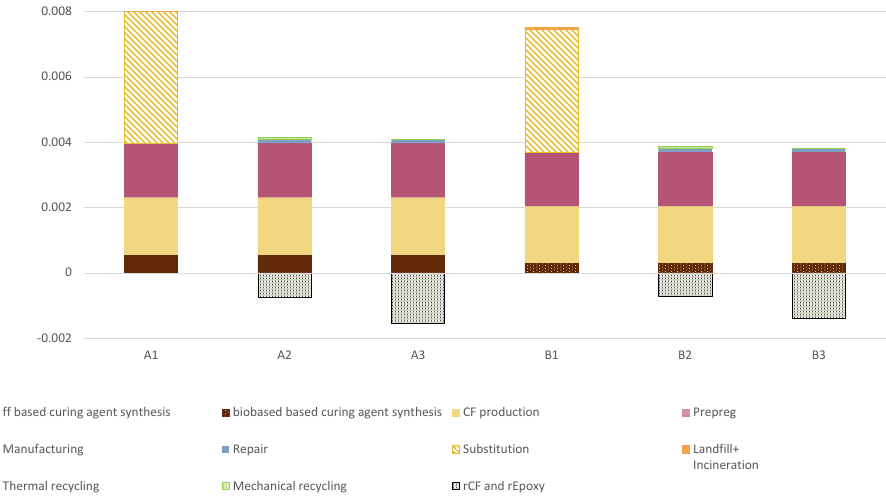
Figure 4. Impact contribution for the 6 scenarios across each life cycle of the FU for the Global Warming impact category. Negative impact values of rCF and rEpoxy are due to the avoided impact of virgin CF and epoxy resin because of their recycling. The quantitative avoided impacts are related to the chosen recycling option and its efficiency of